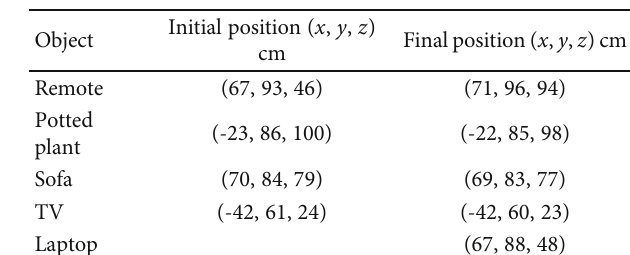
Figure 13: Two views of a simpli fi ed example of virtual scene summary based on the actual segmented point cloud of Figure 12. This simpli fi ed version can further be populated with the actual CAD model of the object for better representation. Table 1: Spatial position of the detected objects with respect to the living room coordinate frame.